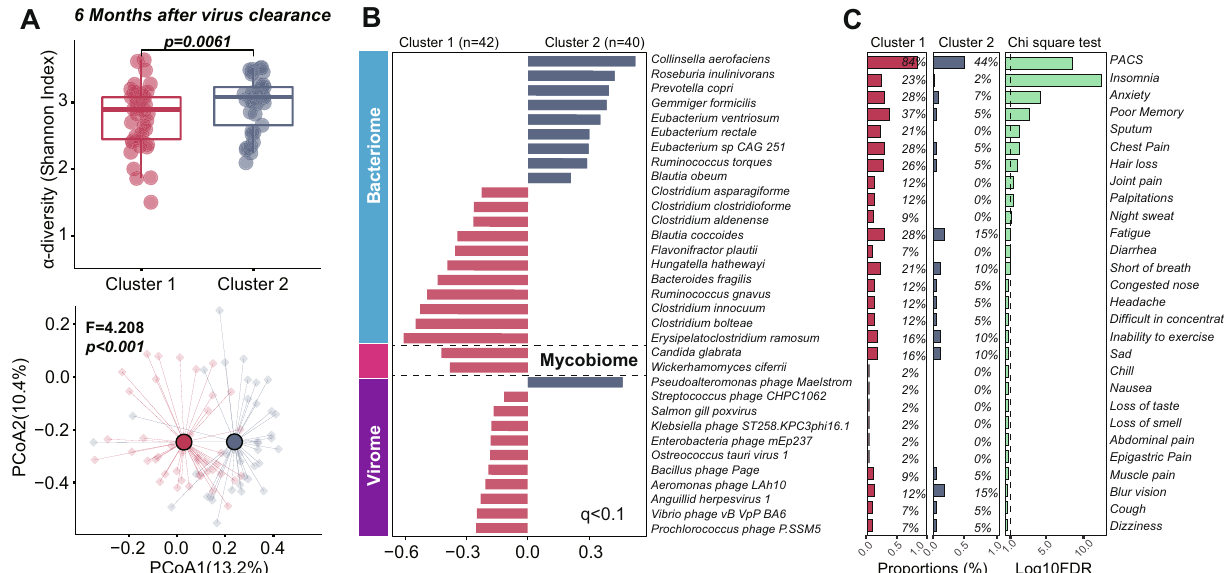
Fig. 3 | Prognostic roles of gut integrative microbiomes for post-acute COVID- 19 syndrome. A Comparison of α -diversity (Shannon diversity index, two-sided Wilcoxon rank-sum test, p =0.029) of patients at 6 months after viral clearance between two identi fi ed patient clusters (Cluster 1 at 6 months, n =42; Cluster 2 at 6 months, n =36) and principal coordinate analysis (PCoA) of gut multi-biome of patients at 6 months after virus clearance based on Bray – Curtis dissimilarity illus- trates two patient clusters (PERMANOVA: Adonis test). The line in the boxplot